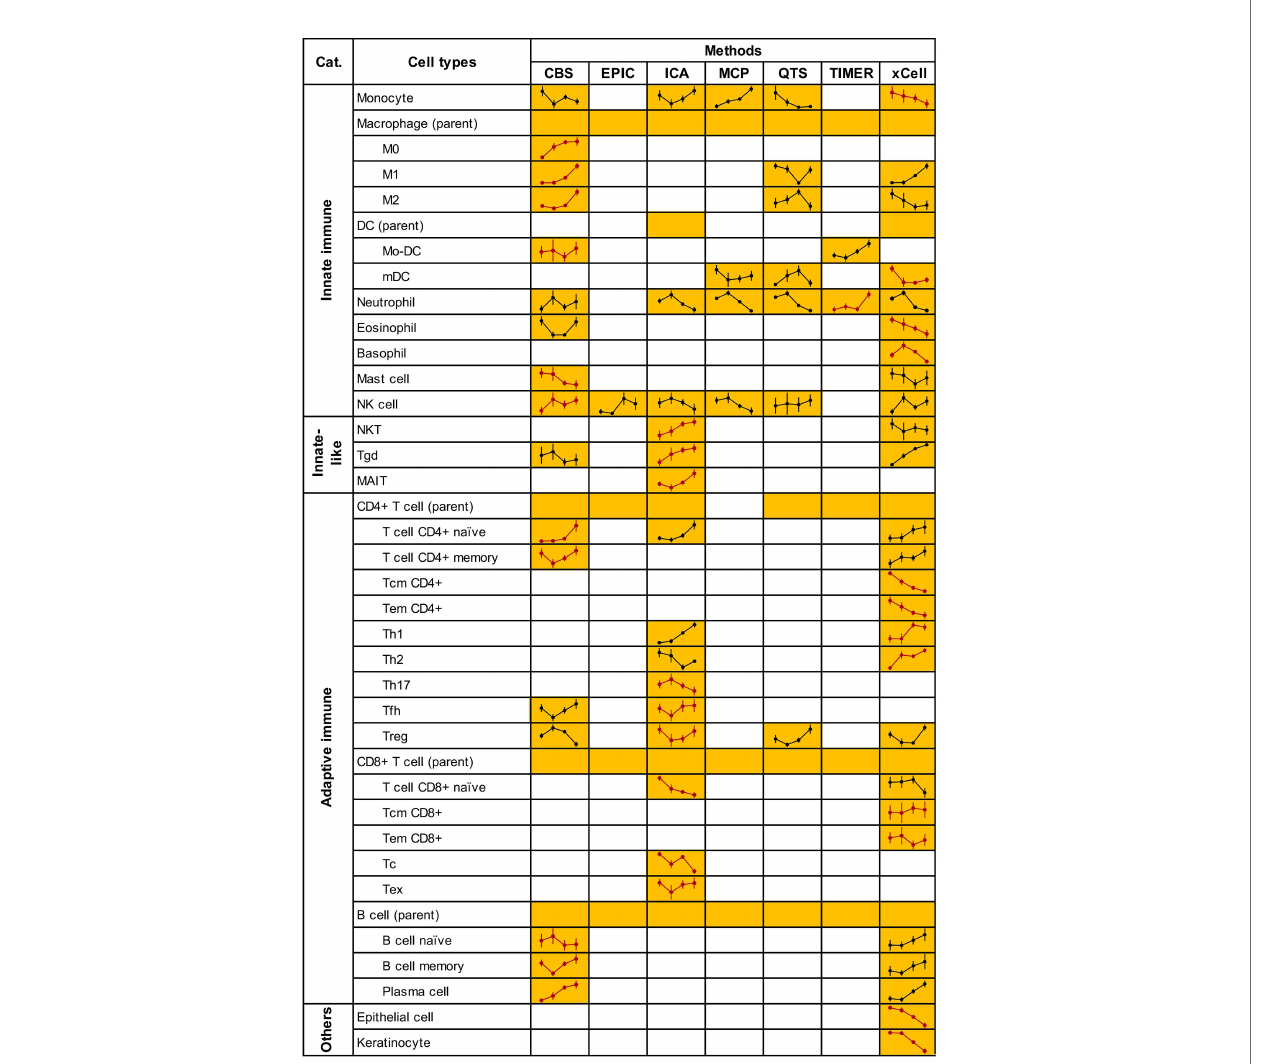
FIGURE 3 | Microenvironment cells and their in fi ltrating patterns. Due to lack of estimation for monocyte by MCP-counter, we used the “ monocytic lineage ” as a surrogate. Treg score was calculated as the sum of “ nTreg ” and “ iTreg ” in ImmuCellAI. CIBERSORTX scores for activated and resting cell types (Mo-DC, mast, NK and CD4 + memory T cells) were also added. Yellow squares indicate that the method could predict the cells content and line plots of the predicted in fi ltrating patterns were added. Blank squares indicate that the method could not predict the cells content. Line plots in red represented the patterns fi nally determined. Full plots with normalized abundance scores of cells are shown in Supplementary Figure 2 . CBS, CIBERSORTX; ICA, ImmuCellAI; MCP, MCP-counter; QTS,